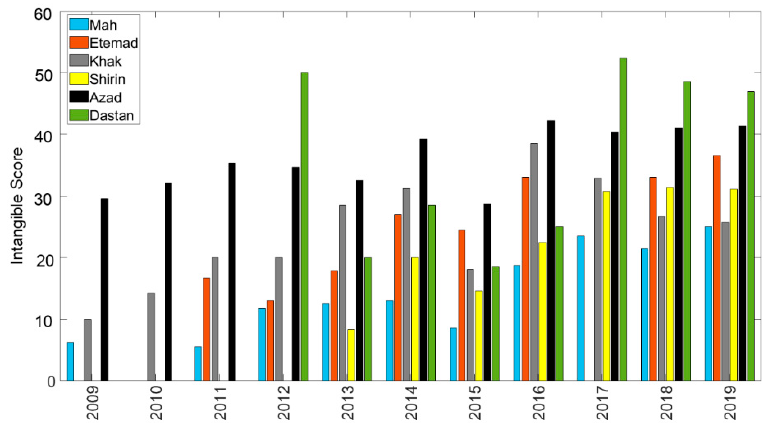
Figure 4. The percentage of exhibitions of new arts in Tehran-based galleries (of total exhibitions).